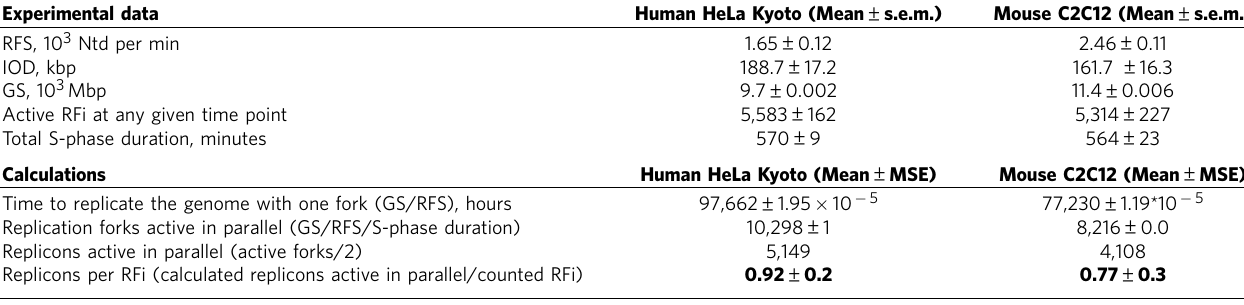
Table 5 | Calculation of the number of replicons per replication focus from the experimental data. Experimental data Human HeLa Kyoto (Mean ±